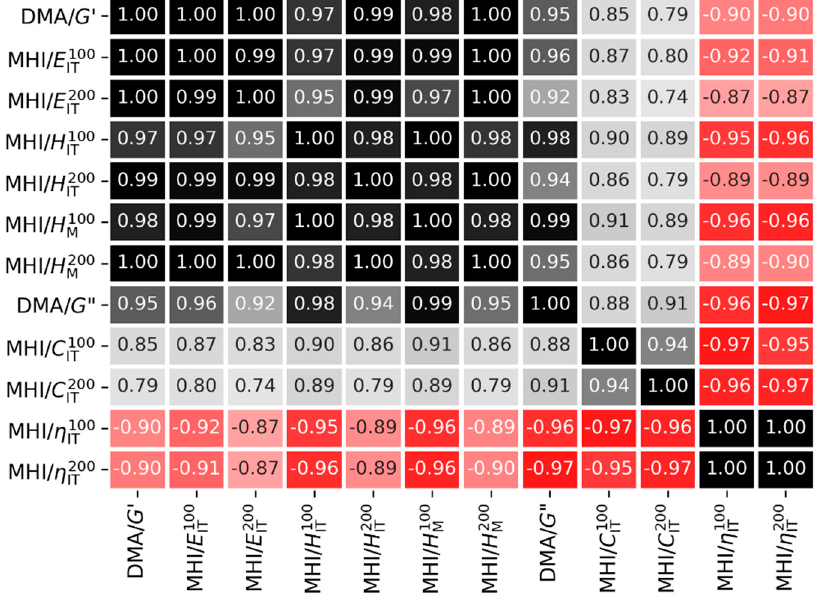
Figure 6. Correlation matrix in the form of a heatmap plot, which summarizes quantitative evaluation of all correlations between macro- and micromechanical properties by means of Pearson’s correlation coefficients r . The strongest positive correlations ( r -coefficients close to +1) are marked with black color, the strongest negative linear correlations ( r -coefficients close to − 1) are marked with red color.